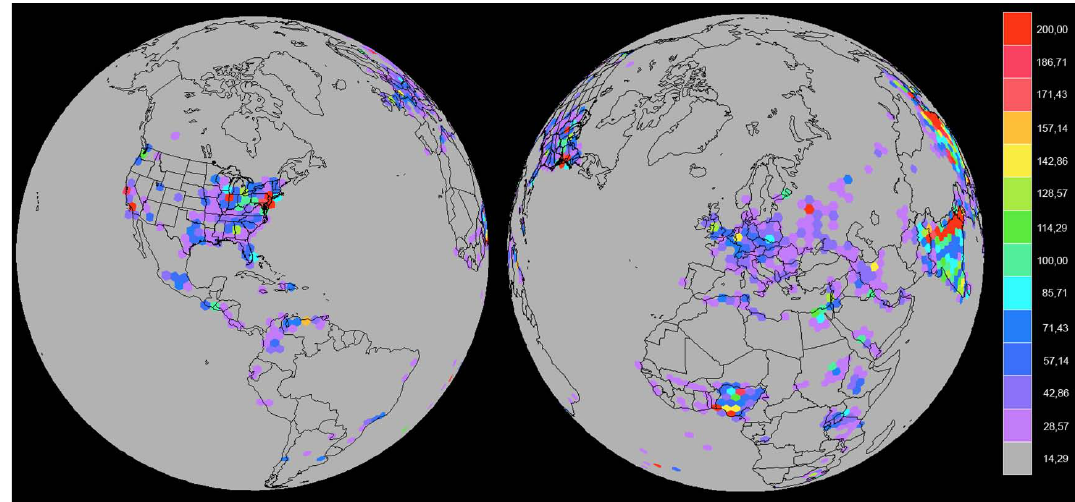
Fig. 7. Carbon monoxide emission field generated by the PREP-CHEM-SRC program for the icosahedral grid (level G5, resolution around 250km) of FIM